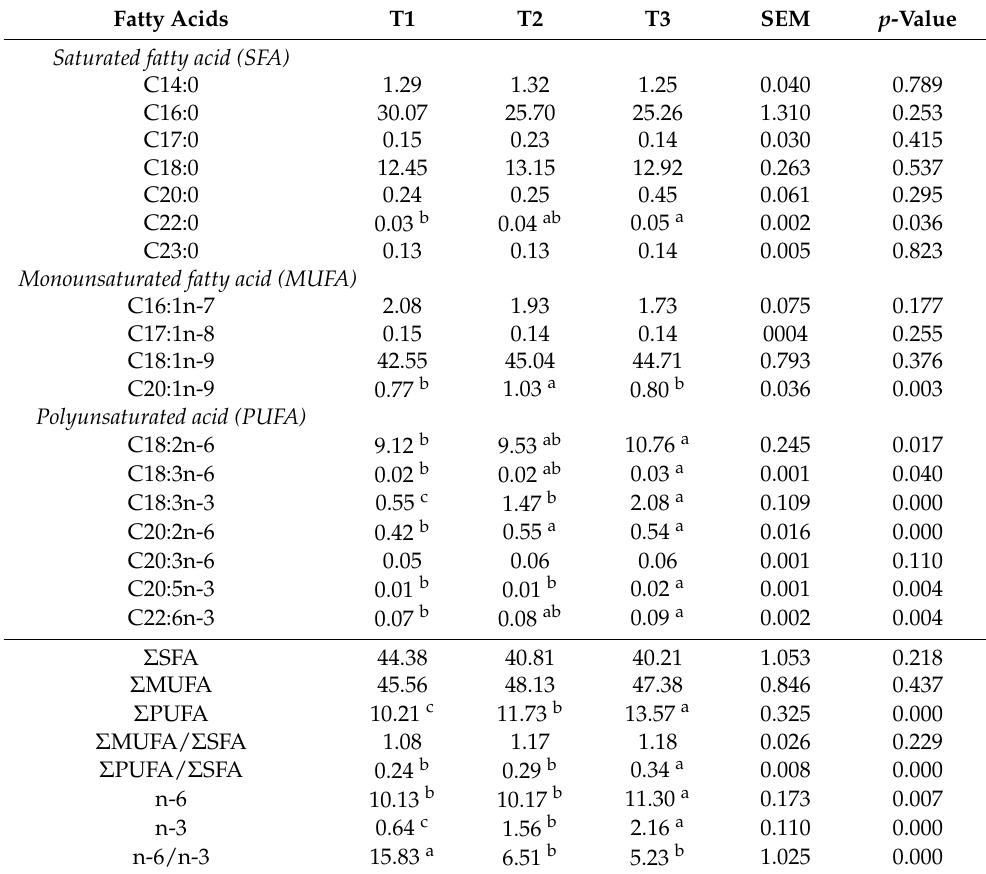
Table 6. Fatty acid composition of backfat from finishing crossbred pigs fed a low-lysine diet supplemented with perilla cake (g/100 g of total fatty